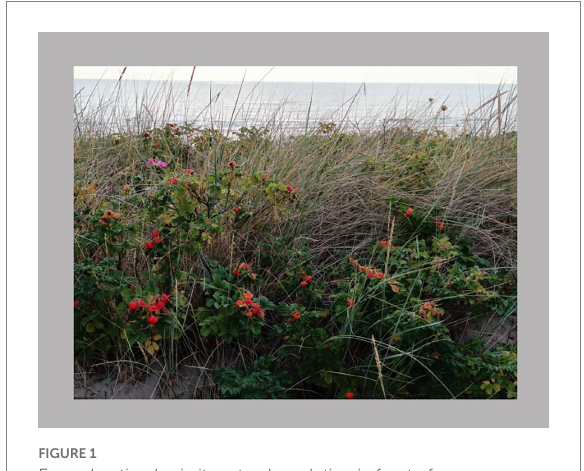
FIGURE 1 Example-stimulus in its natural resolution in front of a grey background. Note that the picture shown is not actually part of the used stimulus-set to not make IAPS-pictures publicly